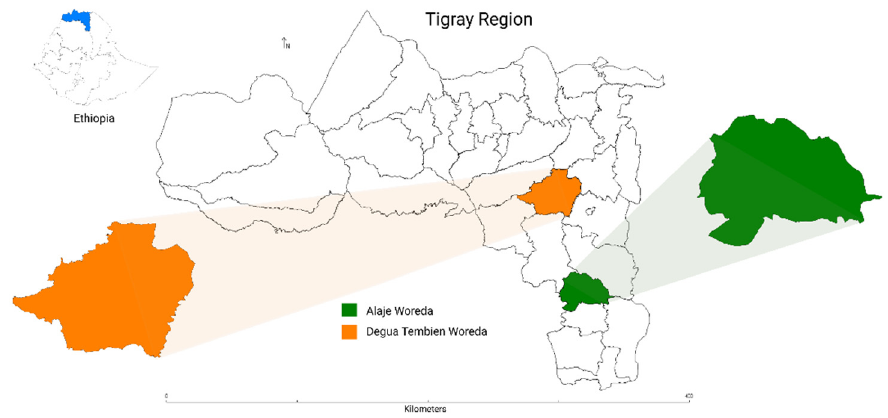
Figure 1. Location map of the study districts in the Tigray Region .